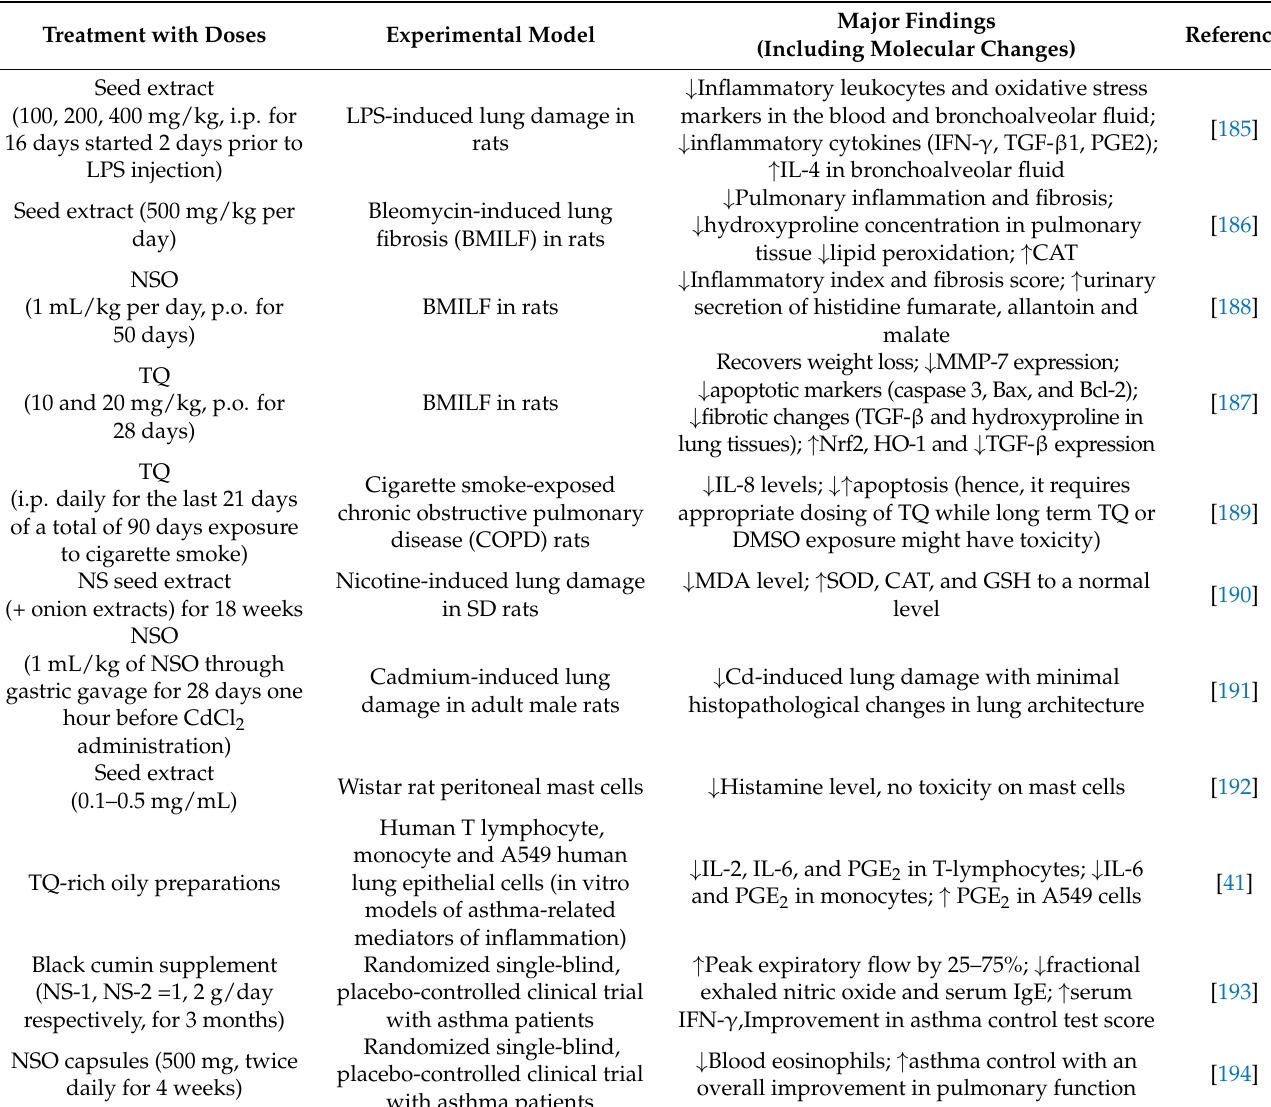
Table 7. Comprehensive summary on the pulmonary protective effects of black